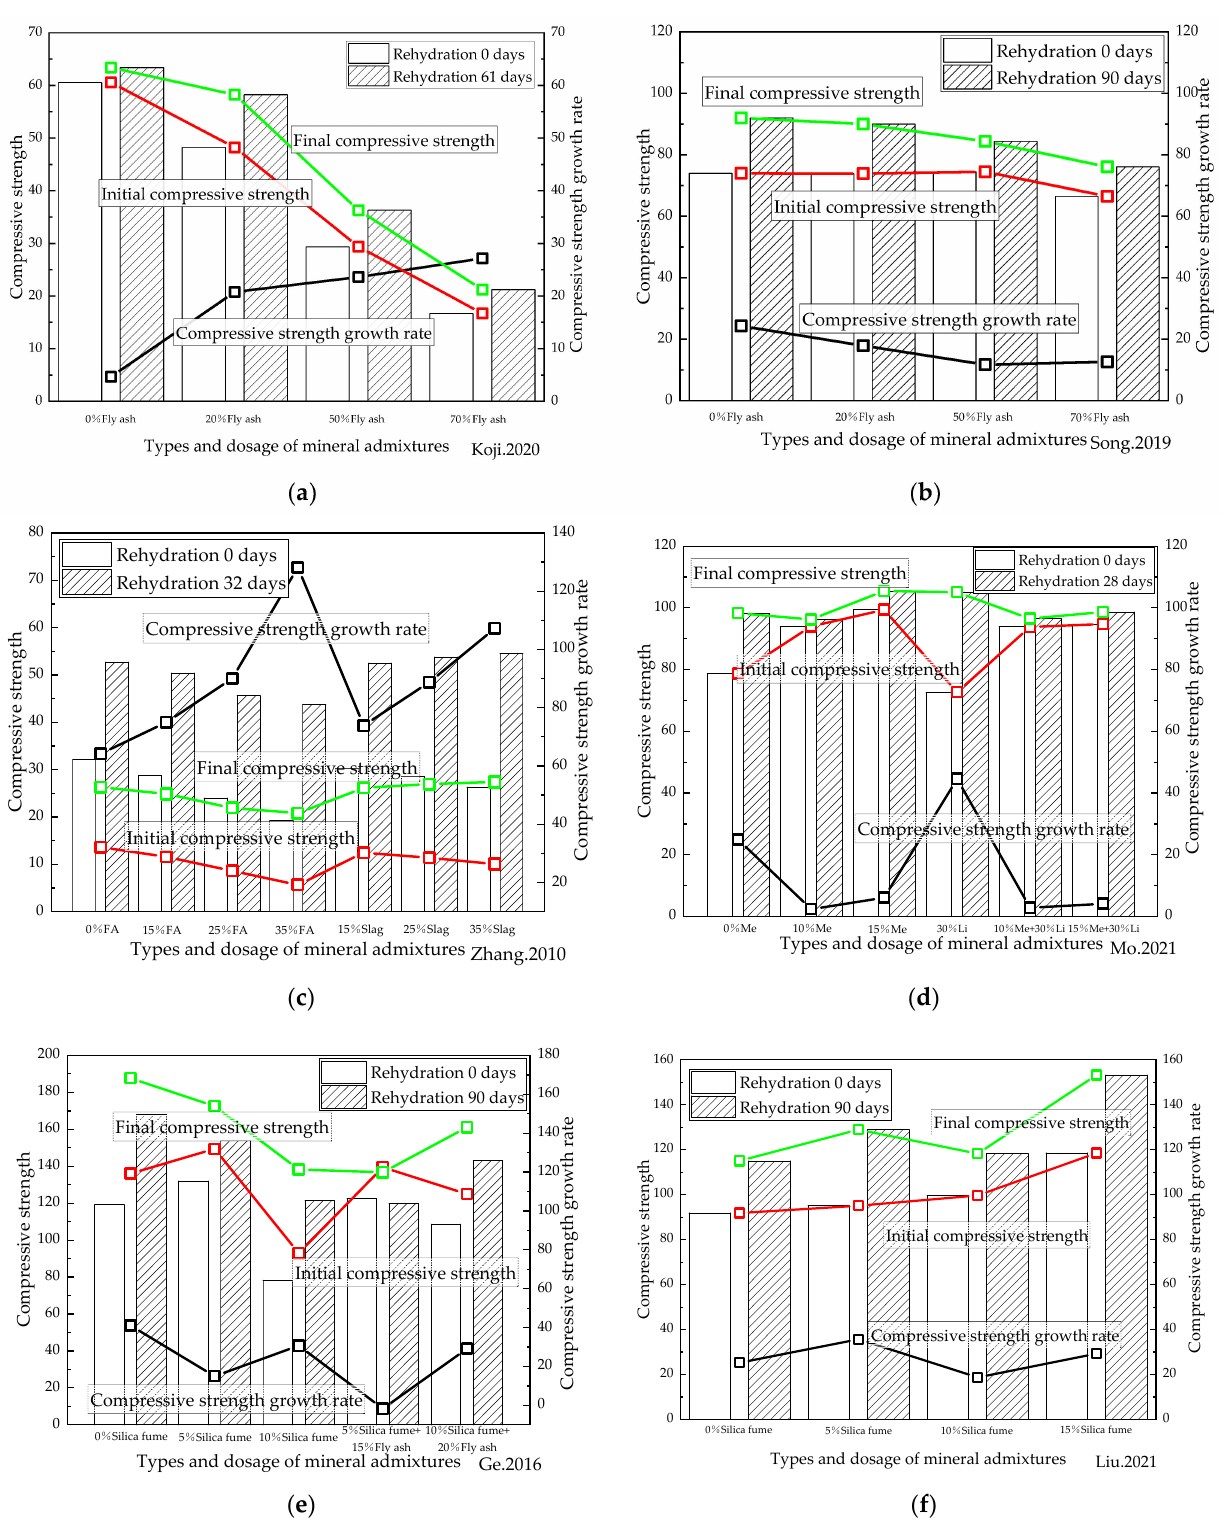
Figure 10. Relationship between the types and dosage of mineral admixtures and rehydration. ( a ) [48] (W/B = 0.4); ( b ) [50] (W/B = 0.3); ( c ) [53] (W/B = 0.35); ( d ) [55] (W/B = 0.2); ( e ) [60] (W/B = 0.17); ( f ) [61] (W/B = 0.2). Me is metakaolin, Li is limestone powder, and FA is fly ash.